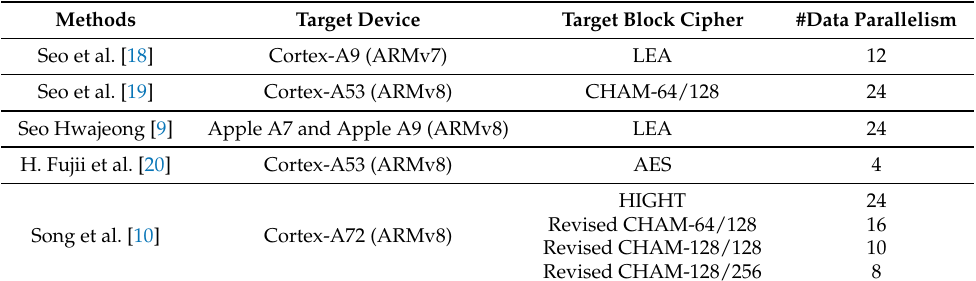
Table 4. Previous block cipher implementations using NEON engine (#Data parallelism: the number of encryptions performed simultaneously on NEON